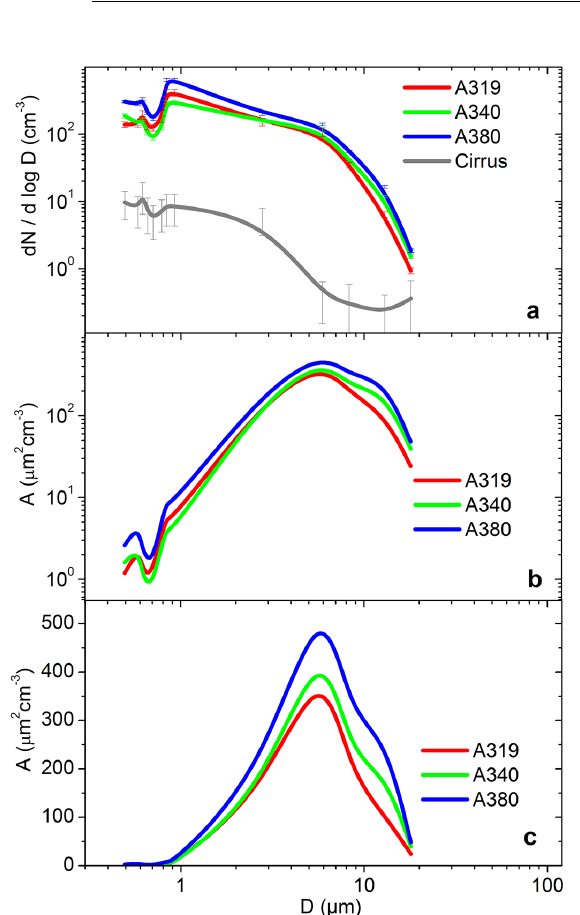
Fig. 3. Particle size distribution (a) and projected planar surface area distribution in logarithmic scale (b) and linear scale (c) of the se- lected contrail sequences from A319, A340 and A380 aircraft ver- sus particle diameter D . Higher total particle concentrations are ob- served in the contrails from heavier aircraft (A380: 580 Mg, A340: 150 Mg, A319: 47 Mg), also leading to higher surface area distri- butions. The maximum in the surface distribution at a diameter near 7µm dominates the optical properties of the contrails. The error bars correspond to errors in counting statistics and are small due to large particle numbers. In panel (a) the particle size distribution of a sur- rounding cirrus cloud is also shown for reference. Obviously, effects by ambient cirrus clouds on the microphysical contrail properties are negligible.